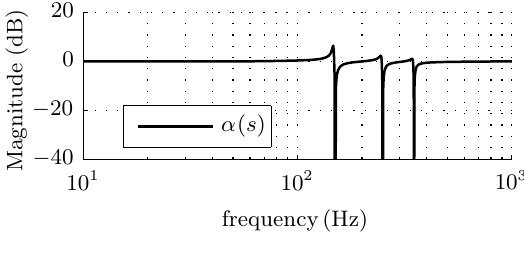
Figure 5. Magnitude response of α ( s )